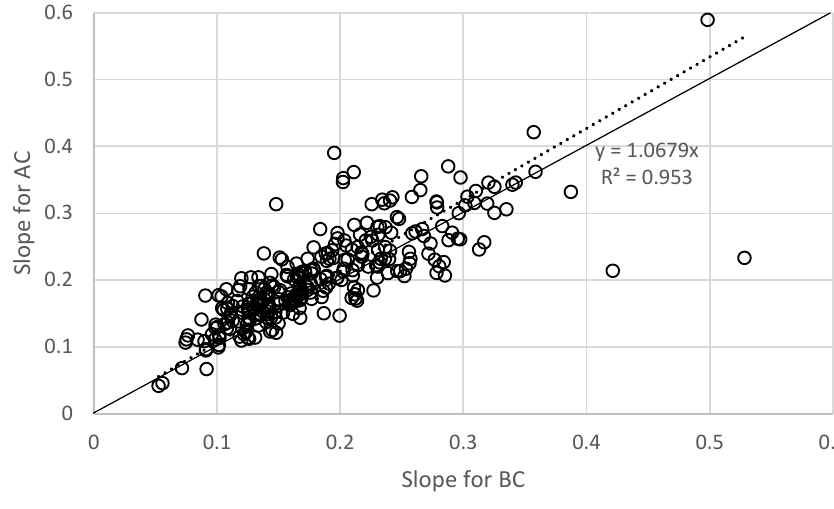
Figure 14. Comparison of absolute of slopes in BC and AC.